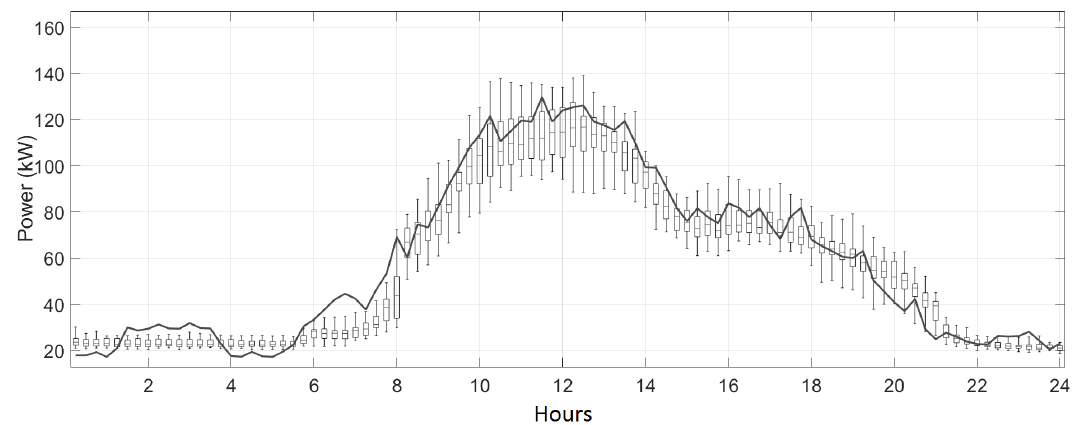
Figure 15. Analyzed Friday compared with the consumption pattern applying the seasonality analysis of electricity consumption method